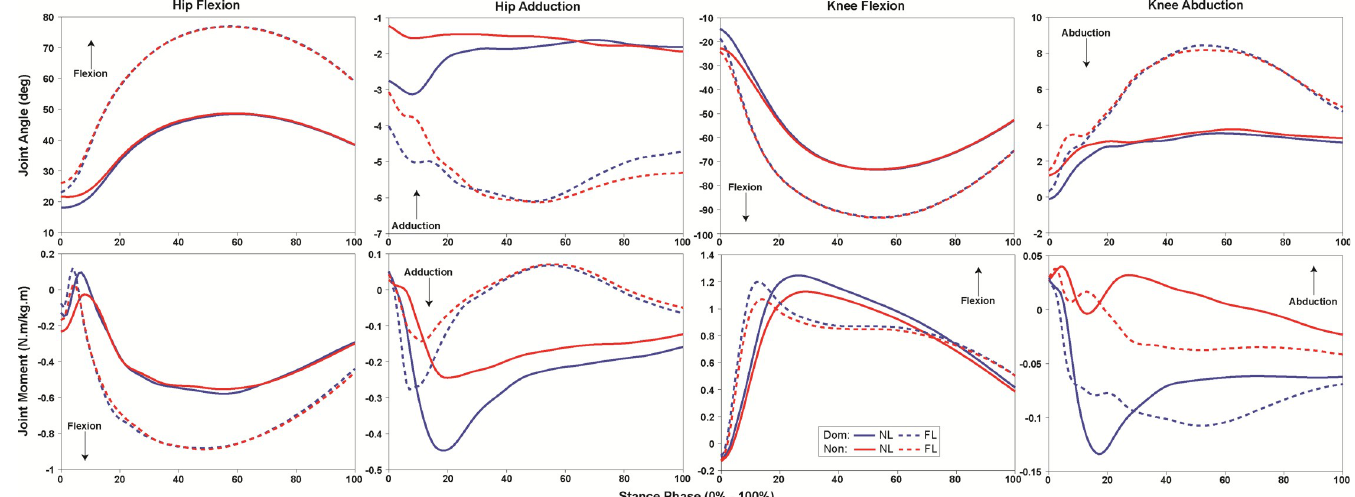
Fig 4. Landing phase (0–100%) hip and knee joint range of motion (ROM) and moments exhibited by the dominant (blue) and non-dominant limb (red) during normal (NL, solid line) and flexed (FL, dashed line) landing.